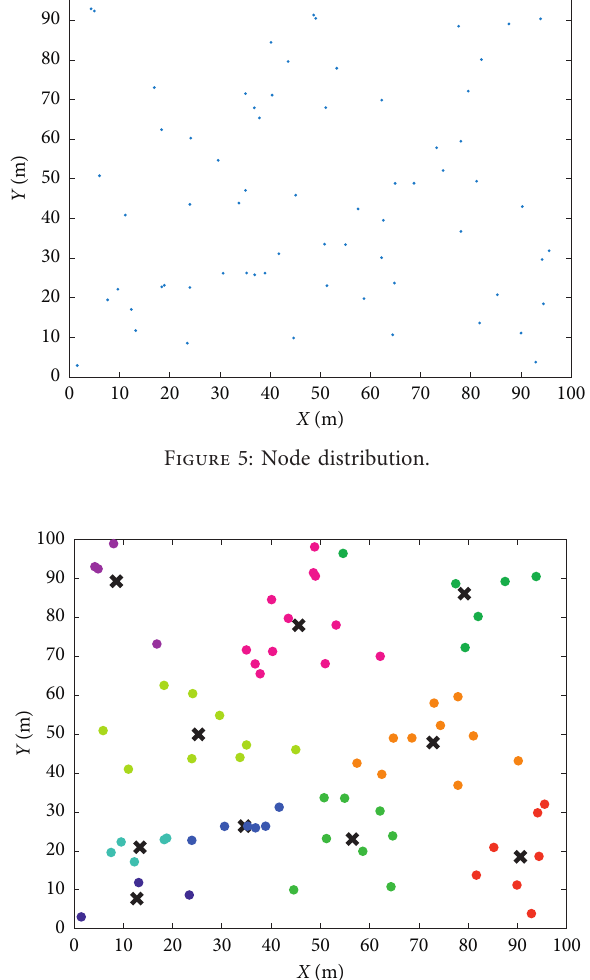
Figure 6: Node clustering and the cluster heads.